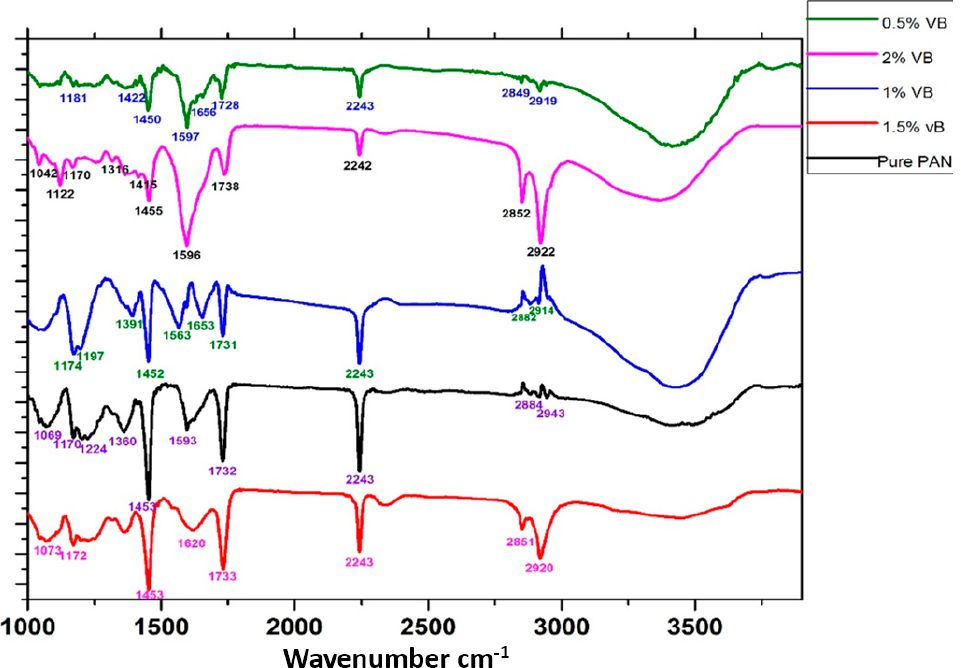
Figure 3. FTIR analysis of prepared electrospun nanofibers.